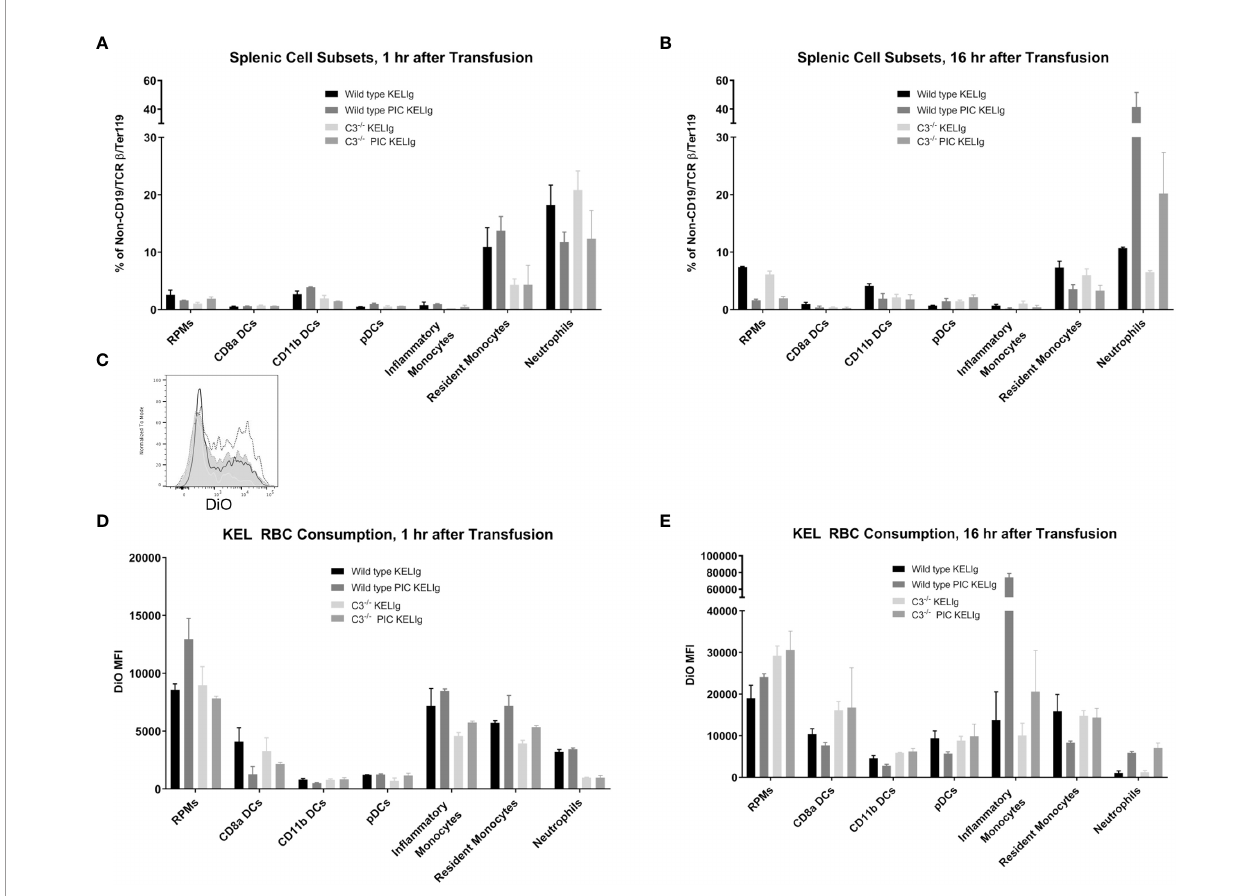
FIGURE 4 | Poly (I:C) and KELIg immunoprophylaxis result in increased transfused KEL RBC consumption by splenic in fl ammatory monocytes in wild type compared with C3 -/- mice. DiO labeled KEL RBCs were transfused to wild type or C3 -/- mice treated with KELIg in the presence or absence of poly (I:C) and splenic cell subsets were evaluated at 1 and 16 hours post-transfusion (A, B) . (C) Representative histograms for DiO RBC fl uorescence patterns of in fl ammatory monocytes at 16 hours post- transfusion, after fi rst excluding TER119 positive RBCs on the exterior of the splenic cells; black open histogram is KELIg in wild type, dotted open histogram is KELIg and PIC in wild type; white shaded histogram is KELIg in C3 -/- and dotted shaded histogram is KELIg and PIC in C3 -/- . DiO mean fl uorescence intensity (MFI) of the splenic cell subsets was evaluated at 1 hour (D) and 16 hours (E) post-transfusion. These data are representative of 2-3 independent experiments with 3 mice/group/experiment; error bars indicate standard deviation between